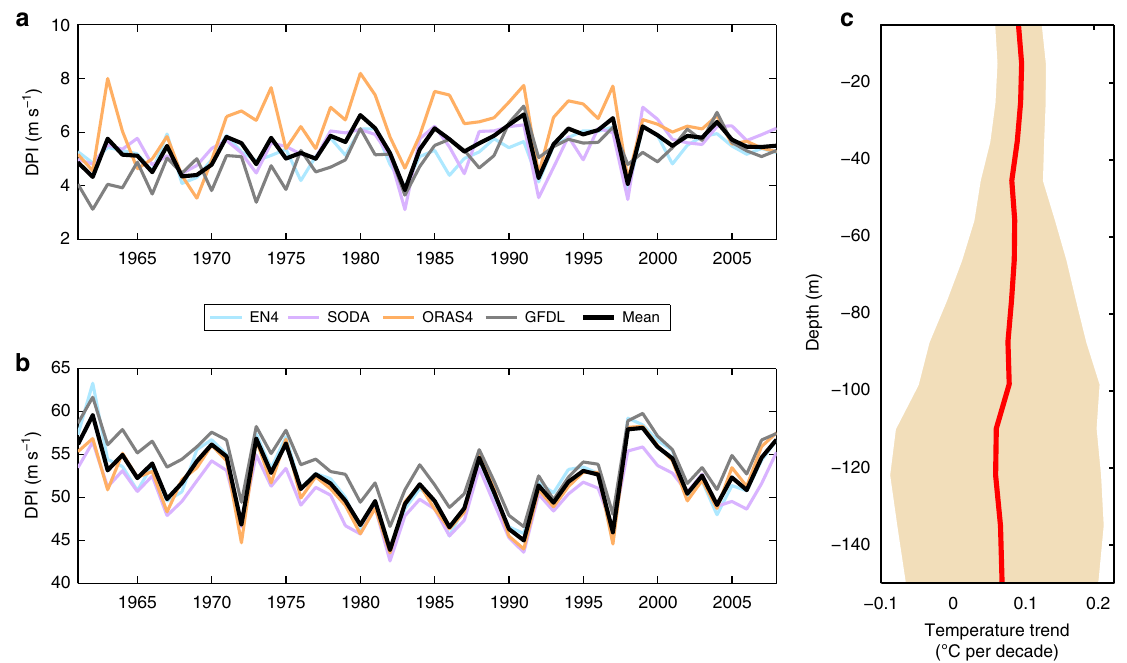
Figure 2 | Observed trends in salinity and temperature impacts on super typhoon intensification. Time series of ( a ) salinity and ( b ) temperature contribution to typhoon-season mean Dynamic Potential Intensity (DPI) for super typhoons (STY), averaged over the region 130 (cid:2) E–150 (cid:2) E and 5 (cid:2) N–25 (cid:2) N (see box in Fig. 1a), in ms (cid:2) 1 per decade for various ocean data products (EN4, light blue; SODA, purple; ORAS4, orange; GFDL, grey) and the mean of all products (black). ( c )Trends in typhoon-season mean subsurface temperature, averaged over the region 130 (cid:2) E–150 (cid:2) E and 5 (cid:2) N–25 (cid:2) N (see box in Fig. 1a), in (cid:2) C per decade based on EN4 data. The line represents the median trend value and the shaded area indicates the 95% confidence intervals, estimated using a linear